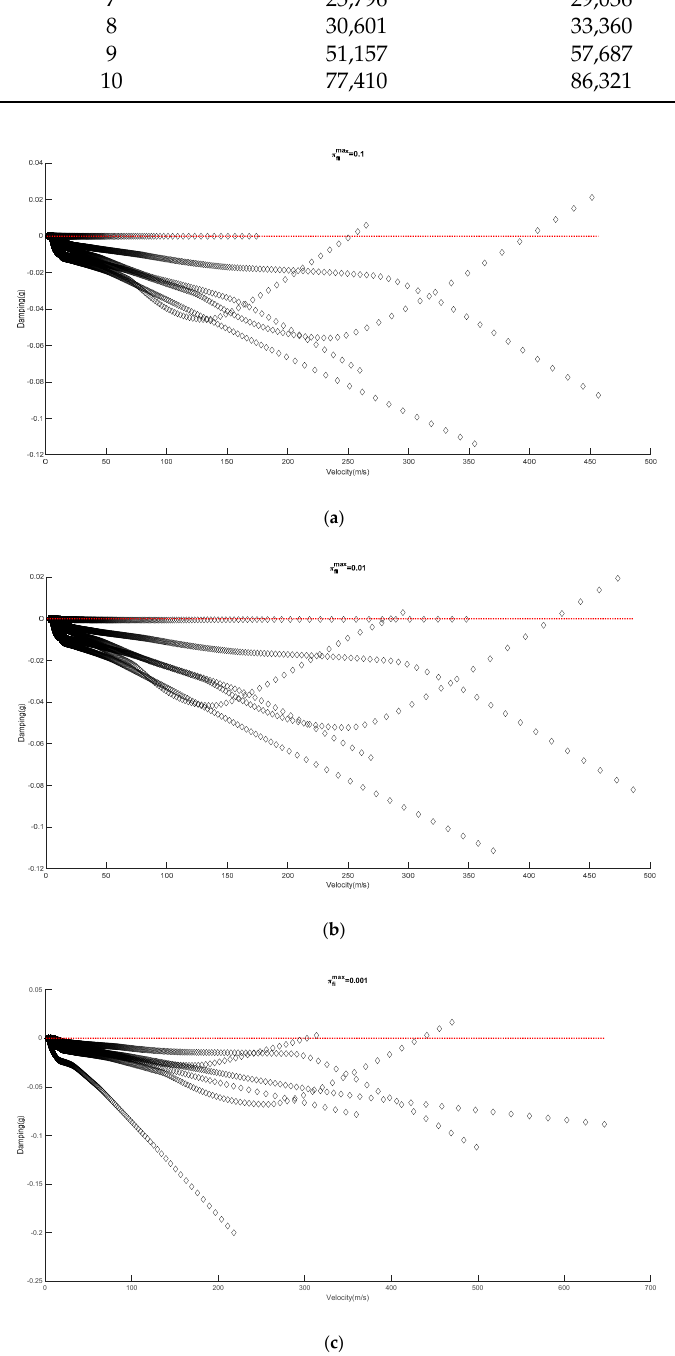
Figure 6. The variations of the PSI at (a) π fimax = 0.1, (b) π fimax = 0.01 and (c) π fimax = 0.001 due to the variation damping ratio vs.